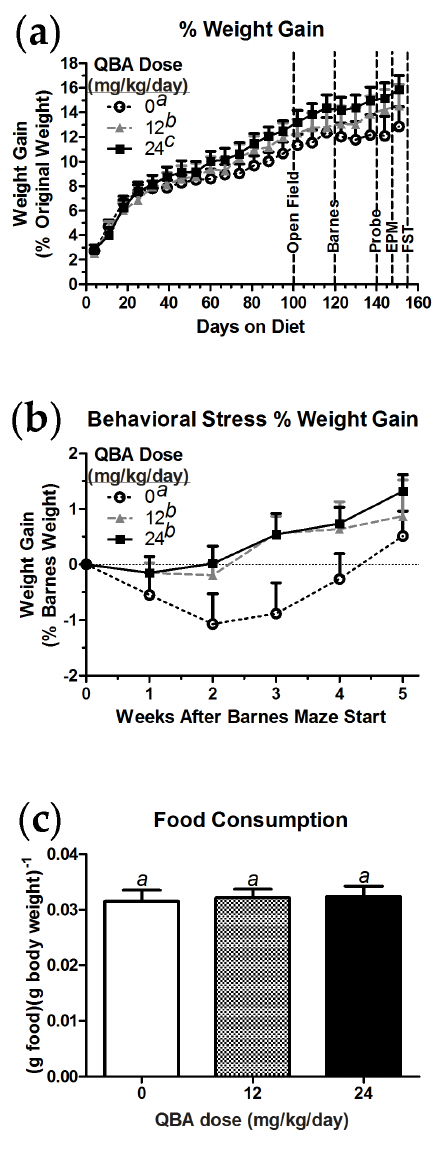
Figure 4. QBA increased the weight of aged male rats and mitigated the weight loss associated with the stress of behavioral assessment. ( a ) All of the animals gained weight as they aged, but QBA-treated animals gained significantly more than controls. The weight-gain differences became more pronounced with the onset of cognitive testing in the Barnes maze at study day 120. ( b ) In comparison to animals that received QBA, the control animals exhibited significant weight loss during behavioral testing in the Barnes and elevated plus mazes. ( c ) The differences in body weight were not due to differences in food consumption. Barnes = Barnes maze task acquisition; Probe = Barnes maze memory probe task; EPM = elevated plus maze testing; FST = forced swim test. Lack of shared superscripts indicates statistically significant differences ( p < 0.05) in Tukey’s post hoc test. N = 11–13 per group. Error bars represent the